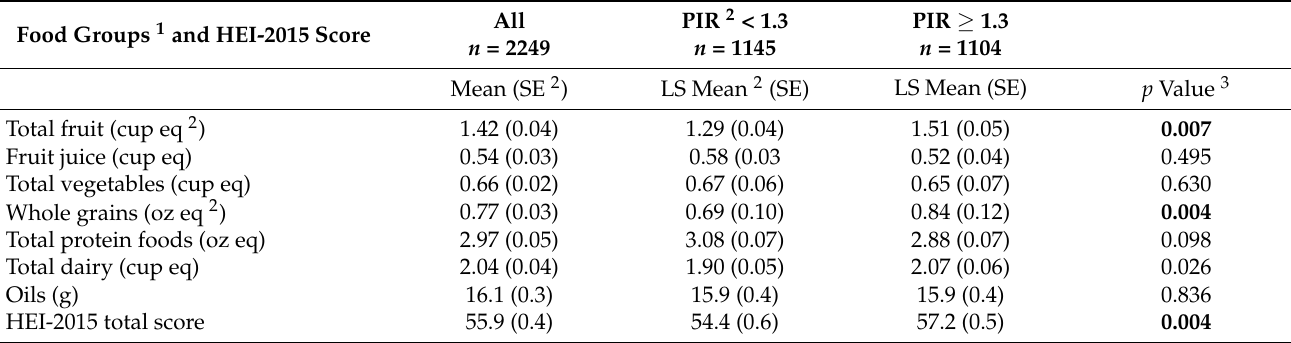
Table 3. Food group intakes and diet quality scores of children 2–5 years, NHANES (2011–2018) by family income to poverty ratio